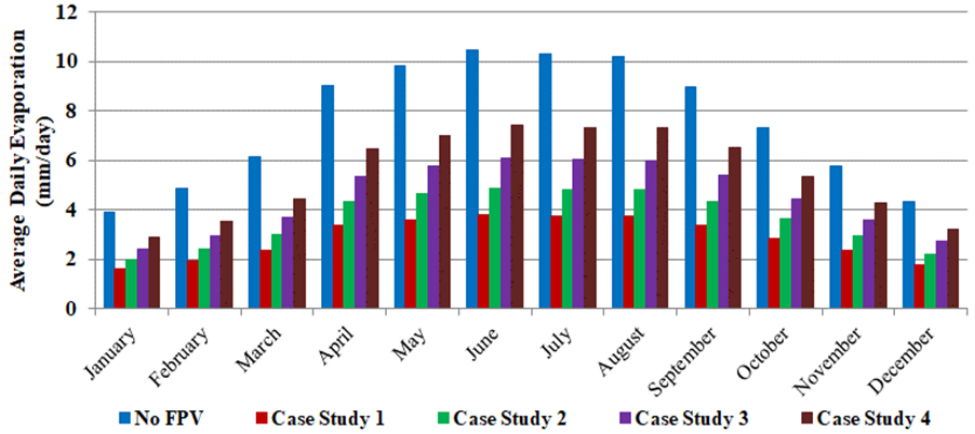
Figure 5. Average daily evaporation for each month throughout the year for the cases with and without FPV panels.